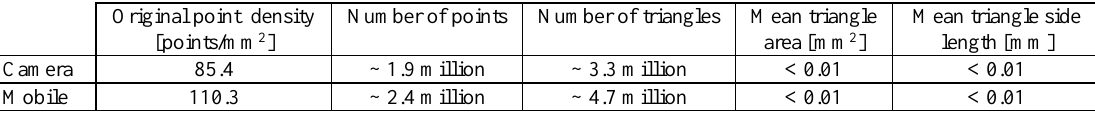
Table 3. Camera and Mobile models with original point